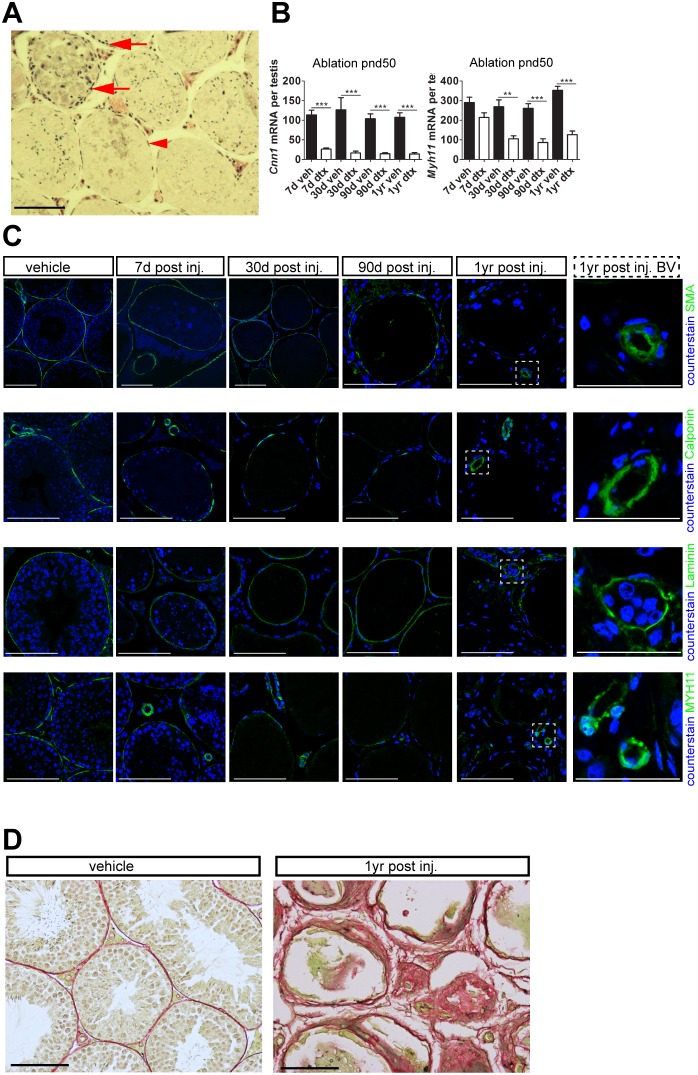
Sertoli Cells regulate PTMC function in adulthood.(A) Testicular histology (2.5 µm resin sections stained with hematoxylin and eosin) shows a single layer of PTMC is retained around seminiferous tubules (red arrowhead) 30 days after Sertoli cell ablation at pnd50 although some disruption of the PTMC layer can be noted (red arrows, associated with a small number of macrophage-infiltrated tubules) (scale bar: 100 µm). (B) Expression of PTMC markers Cnn1 and Myh11 (one-way ANOVA n = 5–9, **P<0.05, ***P<0.001). (C) SMA, Calponin (functional marker), laminin (basement membrane) and MYH11 expression is retained 90 days following Sertoli cell ablation at pnd50. Disruption of SMA, Calponin, laminin and MYH11 is observed one year following ablation (scale bar: 100 µm), although they remain unaffected in testicular vasculature (inset). (D) Consistent with loss of PTMC function a fibrotic phenotype (PSR staining) develops one year following Sertoli cell-ablation (scale bar: 100 µm). d,days; yr,year; dtx, injected with toxin; veh: vehicle control.